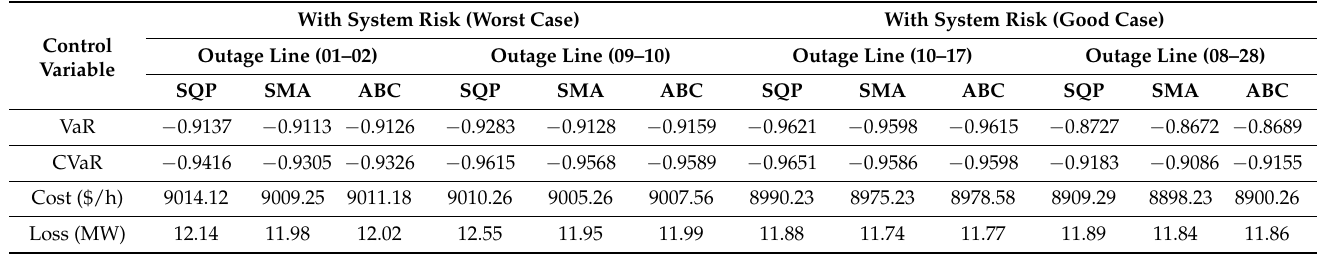
Table 5. Optimal cost and loss values considering system risk for IEEE 30-bus